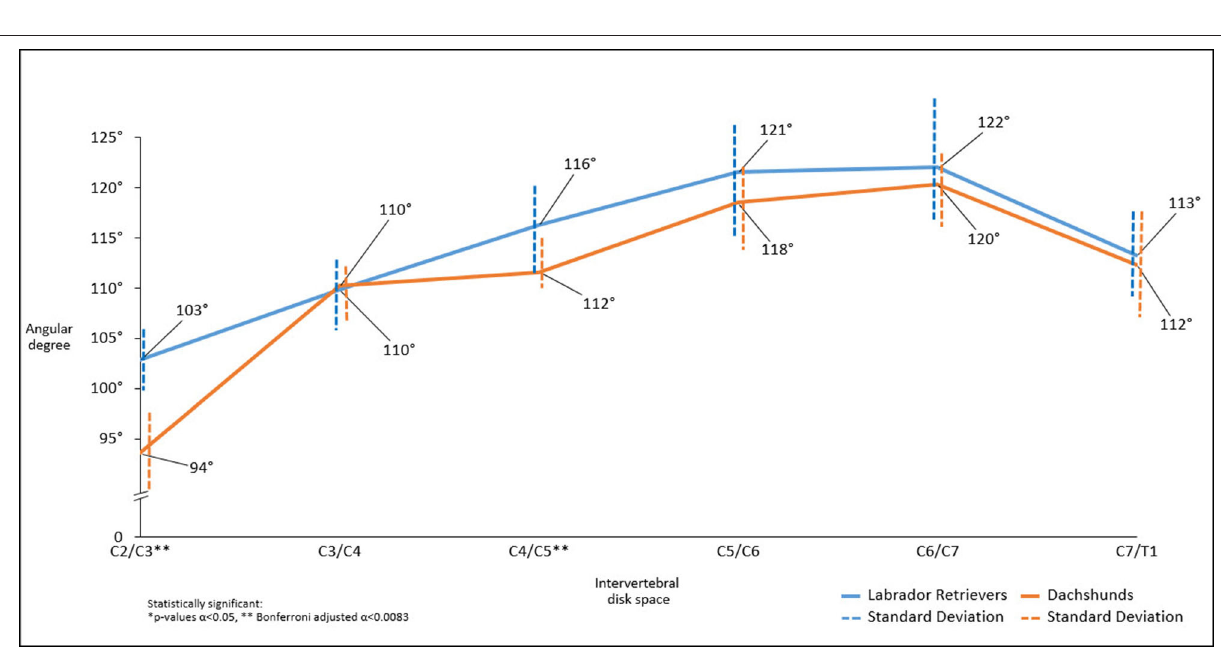
FIGURE 5 | Line graph showing mean angles between IVD space in relation to the axis of the vertebral column along the cervical spine obtained in sagittal plane in computed tomographic images, Dachshunds (orange) and Labrador Retrievers